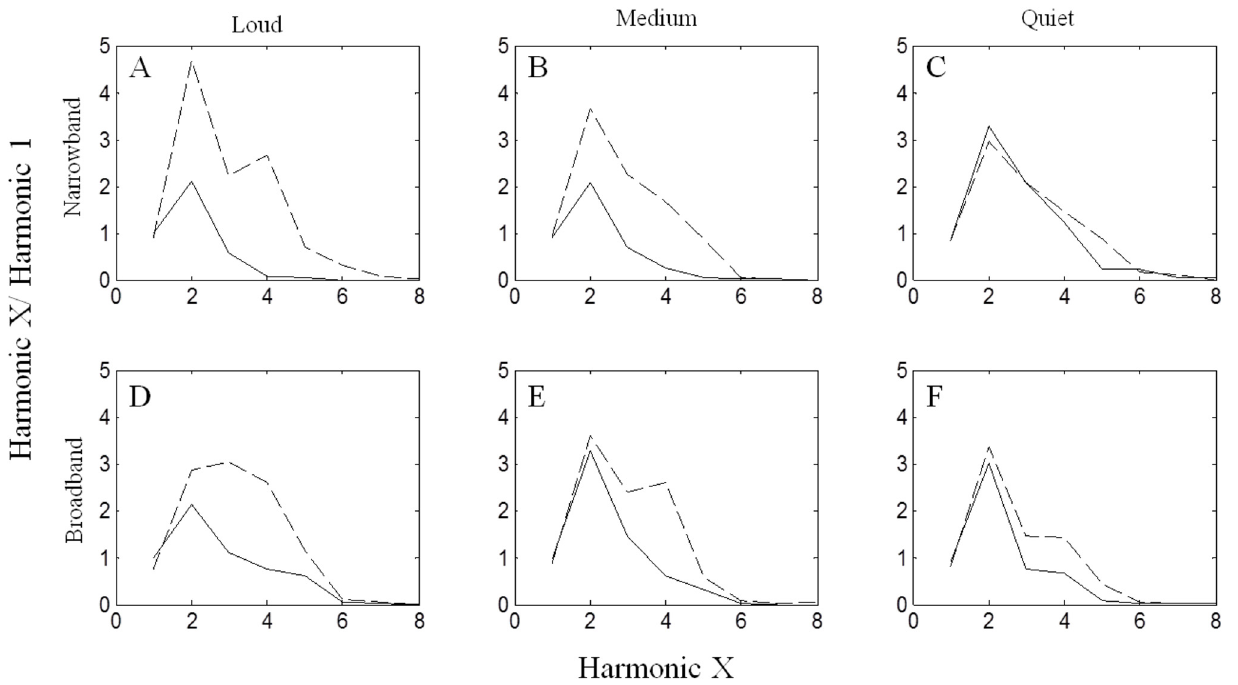
Fig 6. Change in spectral tilt for all 6 noise bandwidth/level combinations. Solid lines indicate control trial values averaged over all animals; dashed lines indicate treatment trial values. Treatments A, B, and C had 5 kHz bandwidth; treatments D, E, and F had 10 kHz bandwidth. The left, middle, and right columns indicate high, medium, and low noise amplitudes, respectively. Panels are arranged by noise level (columns) and bandwidth